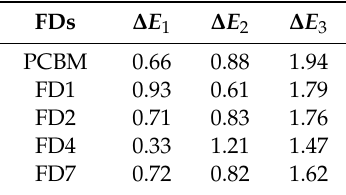
Table 3. Electronic energy level di ff erences of P3HT and fullerene-derivatives (FDs)